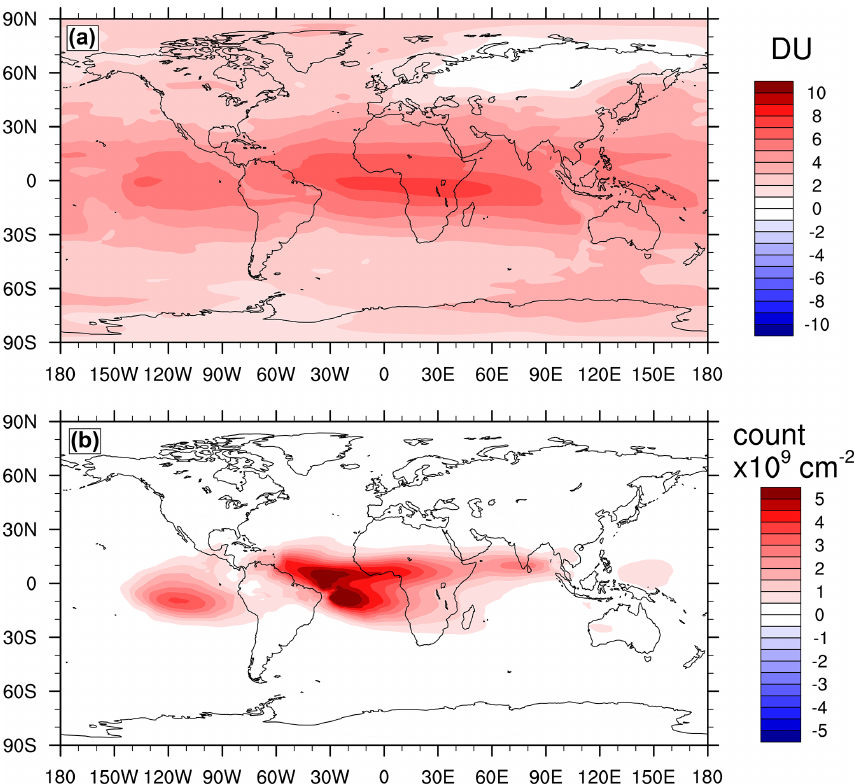
Figure 1. (a) Modelled column ozone difference (DU) and (b) column condensation nuclei (CN) concentration difference (10 9 count per square centimetres) between Run C (i.e. the new dry deposition scheme and the new LNO x scheme) and the base run (mean over 2006–2010).